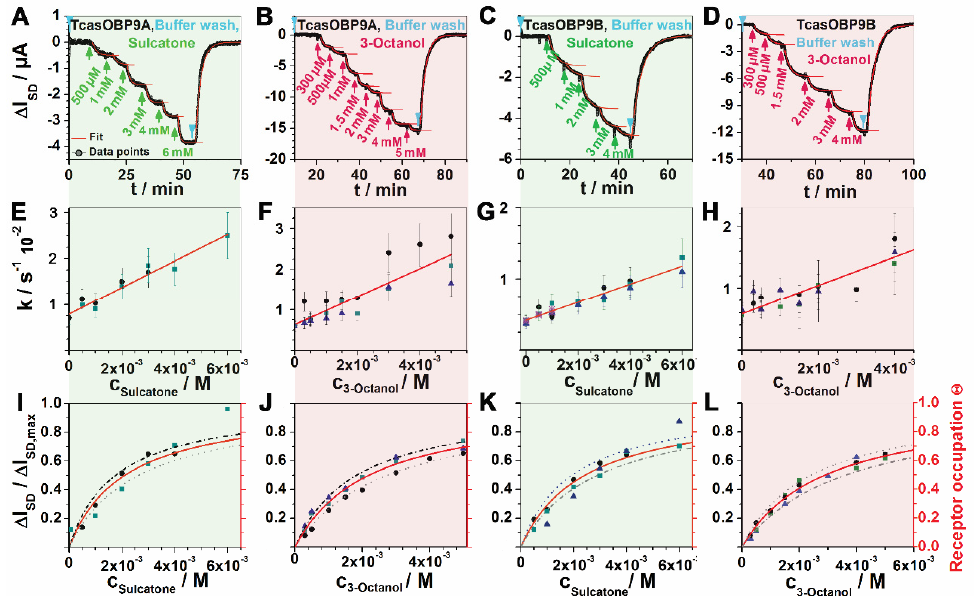
Figure 3. Synthetic receptor kinetics. ( A – D ) The real-time response of synthetic receptors, set up with OBP9A or OBP9B (as shown in panel T) when binding stepwise increasing concentrations of sulcatone or 3-octanol. ( E – H ) Observed rate constants (k) of each concentration step, plotted against the concentration. Intersepts and slopes of the linear regressions yield kinetic off-rates k off and on- rates k on , respectively. ( I – L ) Binding equilibria (thermodynamics) of each OBP/odorant pair above. Responses to each concentration at saturation are plotted against the concentration. Langmuir fits (red curves) yielded the dissociation constants K D . Dotted and dashed-dotted lines indicate ± 20% simulated error ranges. The second (red) ordinate shows receptor occupation. All synthetic receptor responses were measured in